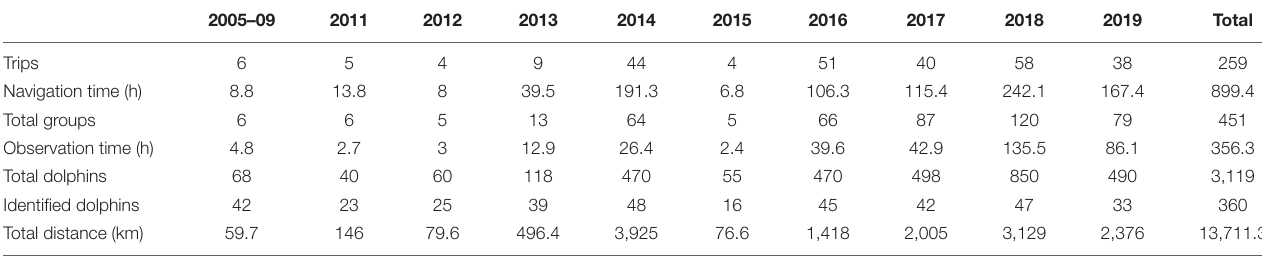
TABLE 1 | The yearly effort made during the study period and the number of groups and dolphins